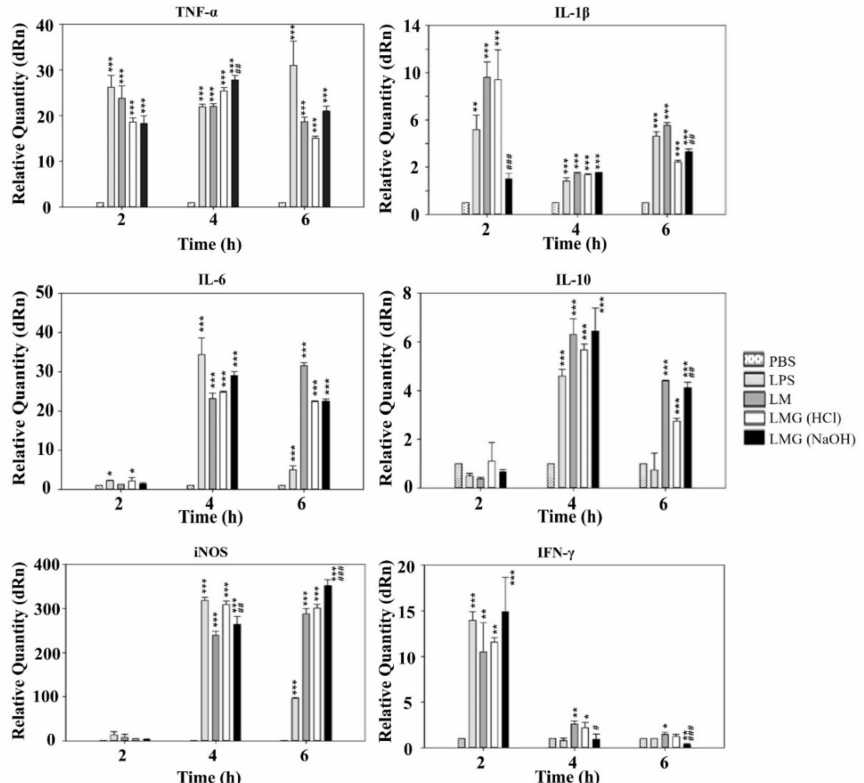
Figure 5. LMGs-exposed murine macrophage (RAW 264.7) stimulates both pro- and anti- inflammatory cytokine production. At 2–6 h post-exposure with LPS from E. coli , L. monocytogenes wild-type cells (LM), HCl-induced LMGs, and NaOH-induced LMGs, each macrophage was collected for analysis of gene expression for cytokines of TNF- α , IL-1 β , iNOS, IL-6, and IL-10 by RT-qPCR. Data are representative of three independent experiments with each sample run in triplicate. All data are expressed as the mean ± the standard error of the mean. *** p < 0.001, ** p < 0.01, and * p < 0.05 indicate a significant difference from a negative control (PBS buffer). ### p < 0.001, ## p < 0.01, and # p < 0.05 indicate a significant difference between HCl-induced LMGs and NaOH-induced